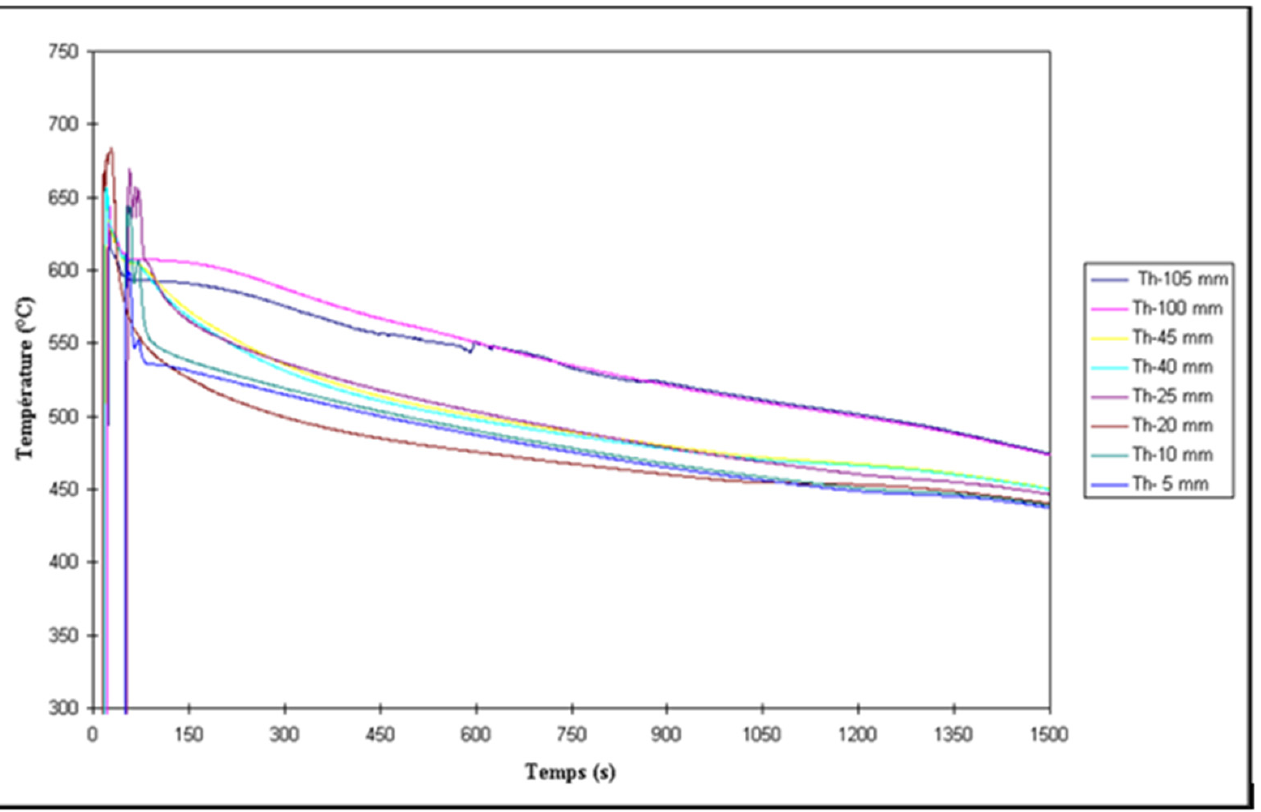
Figure 7. Comparison of melt treatment and hydrogen level on the pore size obtained in three Al-Si based alloys, highlighting the effect of oxides as a function of the total amount of added Sr and grain refiner and hydrogen level. 1.2. Effect of Temperature Temperature is the most important factor that influences the solubility of hydrogen. The dissolution of hydrogen is approximately twenty times higher in the liquid state than in the solid state. The discontinuity in the solubility of hydrogen is observed during the solidification of the metal. The hydrogen dissolved in the metal bath is suddenly rejected through the pasty zone during solidification, which allows the formation of porosities.